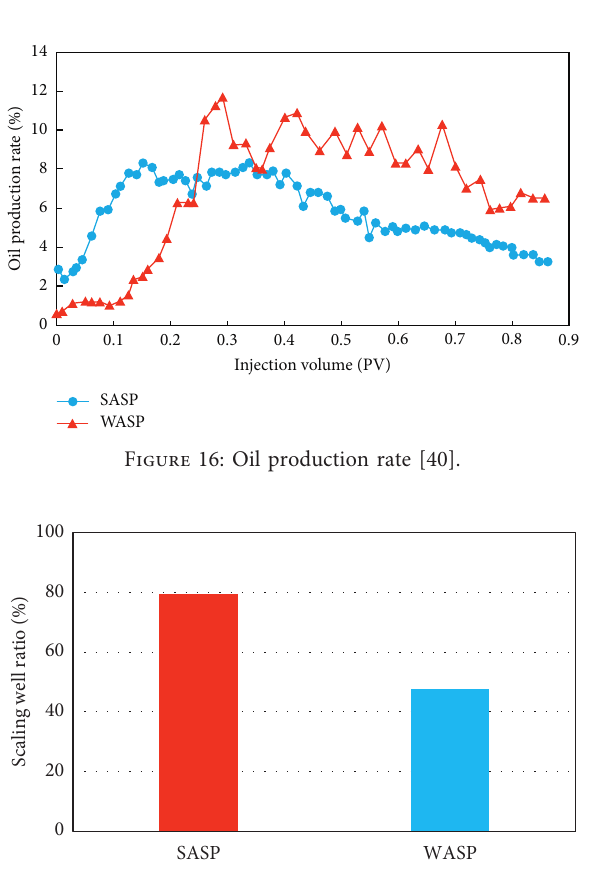
Figure 17: Scaling well ratio